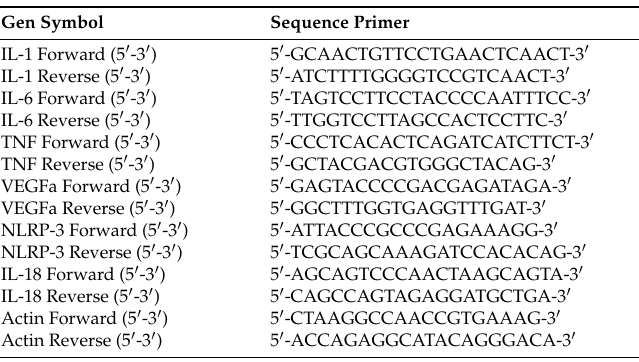
Table 1. Primers used for